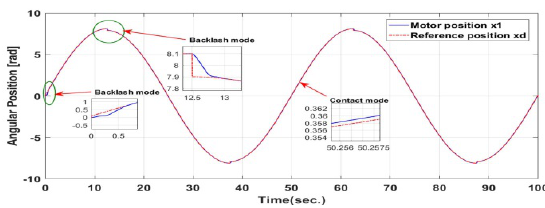
Figure 3. Angle ( x 1 = θ m ) and reference angle x 1 d vs. time for the two-mass system connected by a gearbox